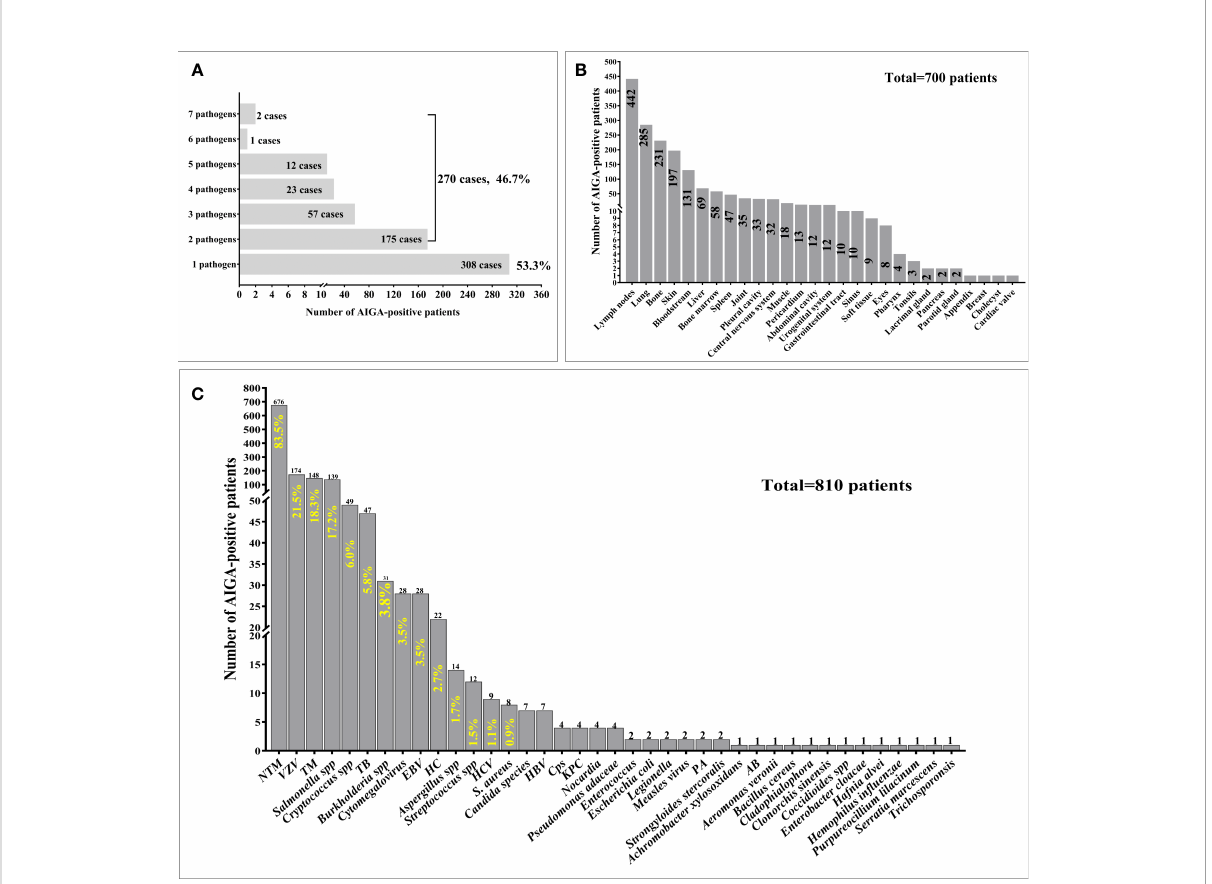
FIGURE 3 Pathogen spectrum and pathogen infection involvement sites of patients with anti-interferon- g autoantibodies positivity. (A) Among 810 patients with AIGA positivity, 578 cases of pathogen infection were described in detail. 46.7% (270/578) of patients were simultaneously or successively infected with multiple pathogens. (B) Among 810 patients with AIGA positivity, 700 cases of pathogen infection involvement sites were described in detail. (C) Thirty-nine pathogens were found among the 810 patients with AIGA positivity. S.Aureus , Staphylococcus aureus , HC Histoplasma capsulatum ; NTM, nontuberculous mycobacteria; TM, Talaromyces marneffe ; TB , Mycobacterium tuberculosis ; VZV , Varicella- zoster virus ; EBV, Epstein-Barr virus ; HBV, Hepatitis B viru s; HCV, Hepatitis C virus ; Cps, Chlamydophila psittaci ; KPC, Klebsiella pneumoniae ; PA, Pseudomonas aeruginosa ; AB, Acinetobacter baumannii